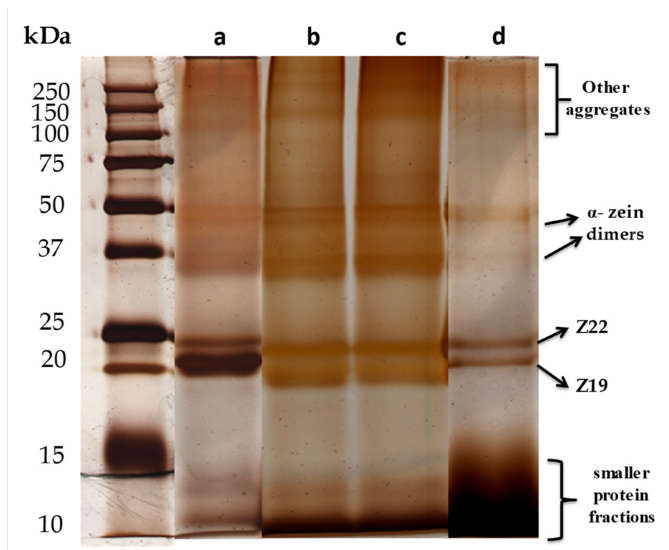
Figure 3. SDS-PAGE profiles in 20% acrylamide of zein after being dissolved in 0.1 M NaOH by (a) magnetic stirring, and under ultrasonication (US) applying total energies of (b) 10, (c) 30, and (d) 60 kJ / 0.5 g of zein. The gel was silver